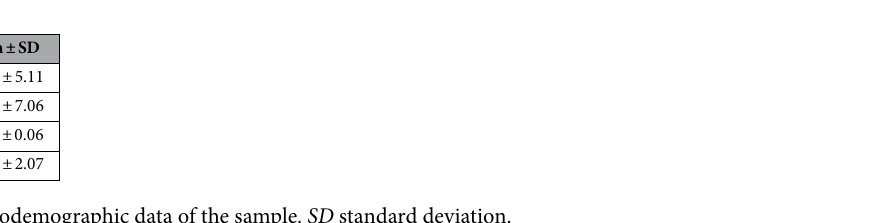
Table 1. Sociodemographic data of the sample. SD standard